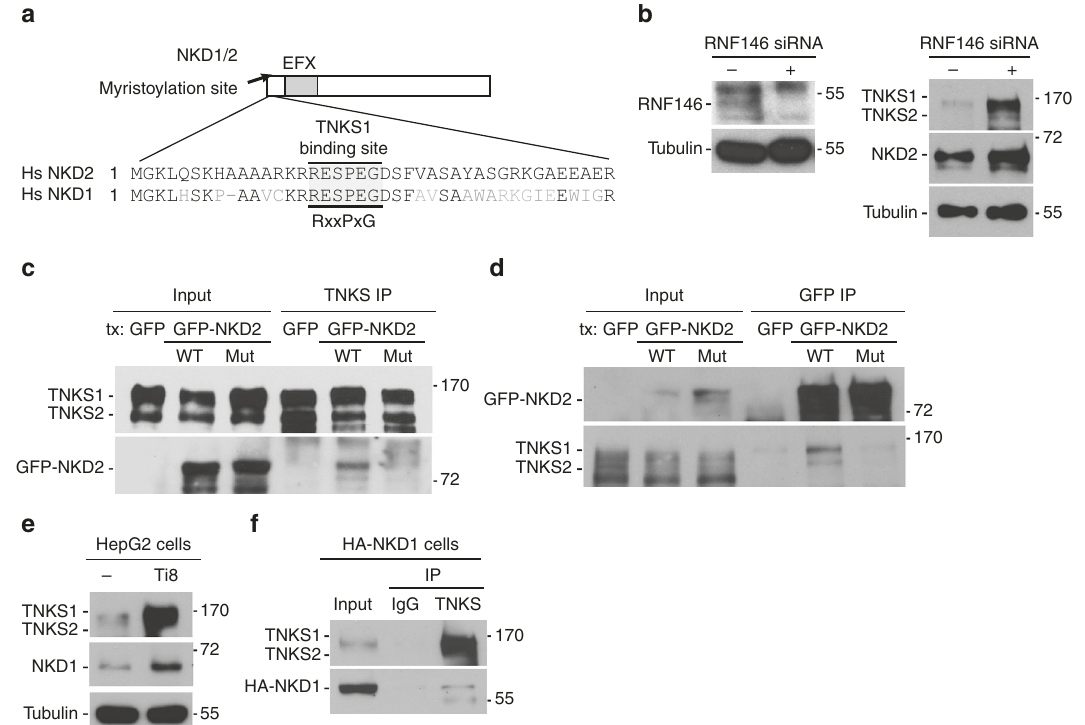
Fig. 5 NKD1 and NKD2 are targets of tankyrase. a Schematic diagram of NKD1/2 showing the N-terminal myristoylation site. The shaded box indicates the conserved EFX (EF-hand containing) domain that binds DVL. Alignment of the tankyrase-binding site in human NKD1 and NKD2. Identical amino acids are in black. b Immunoblot analysis showing NKD2 is stabilized in RNF146 siRNA-treated HEK293T cells. c , d Endogenous tankyrase and GFP-NKD2 coimmunoprecipitate, dependent on the NKD2 tankyrase-binding site. Immunoblot analysis of HEK293T cells transfected with GFP, GFP-NKD2 WT, or GFP-NKD2 Mut, immunoprecipitated with c tankyrase or d GFP antibodies, and probed with the indicated antibodies. e Immunoblot analysis showing that NKD1 is stabilized upon treatment of HepG2 cells with tankyrase inhibitor Ti8. f Immunoblot analysis showing that HA-NKD1 coimmunoprecitates with tankyrase. Immunoblot of HEK293T cells transfected with HA-NKD1, immunoprecipitated with control or TNKS IgG, and probed with the indicated